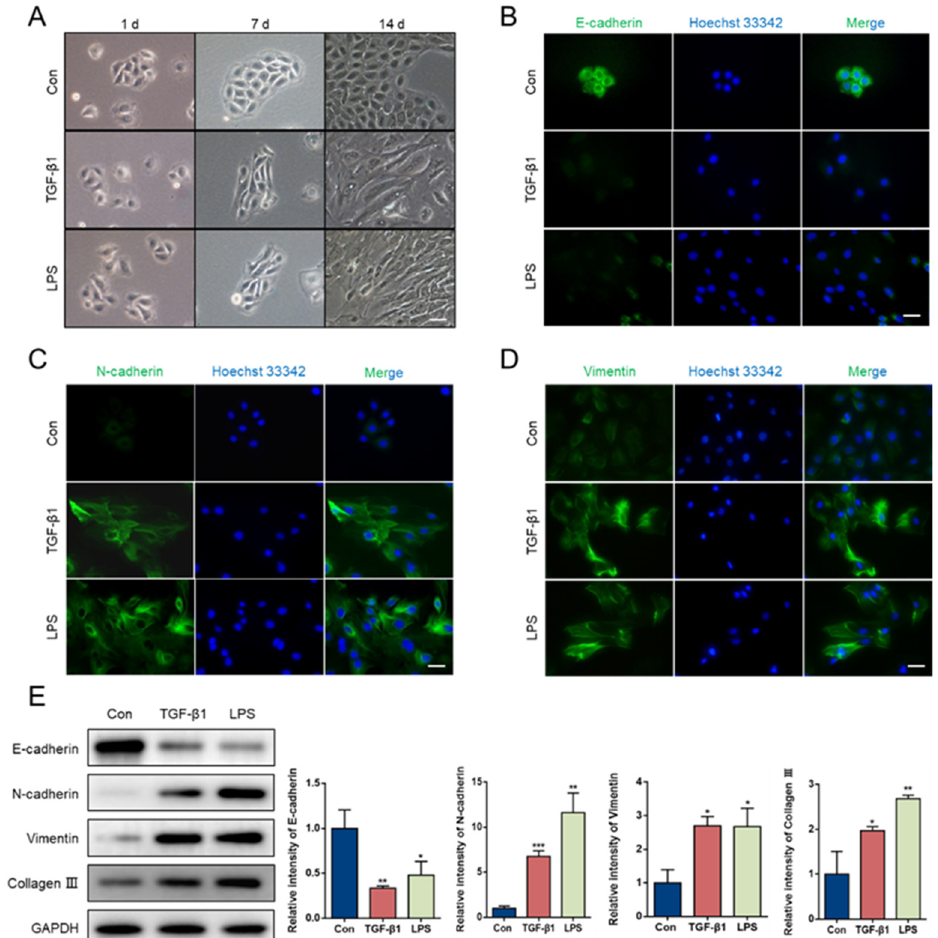
Figure 1. LPS induced EMT in GMECs. ( A ) Changes of cell morphology during LPS (10 μ g/mL) or TGF- β 1 (2.5 ng/mL) treatment. Immunofluorescence staining of E-cadherin ( B ), N-cadherin ( C ) and Vimentin ( D ) in GMECs were observed after LPS or TGF- β 1 treatment for 14 d. ( E ) Western blotting results of EMT markers. (original western blot figures in Figure S1). * Indicates a significant difference compared with the control group, * p < 0.05, ** p <0.01, *** p <0.001. Scale bar = 50 μ m.